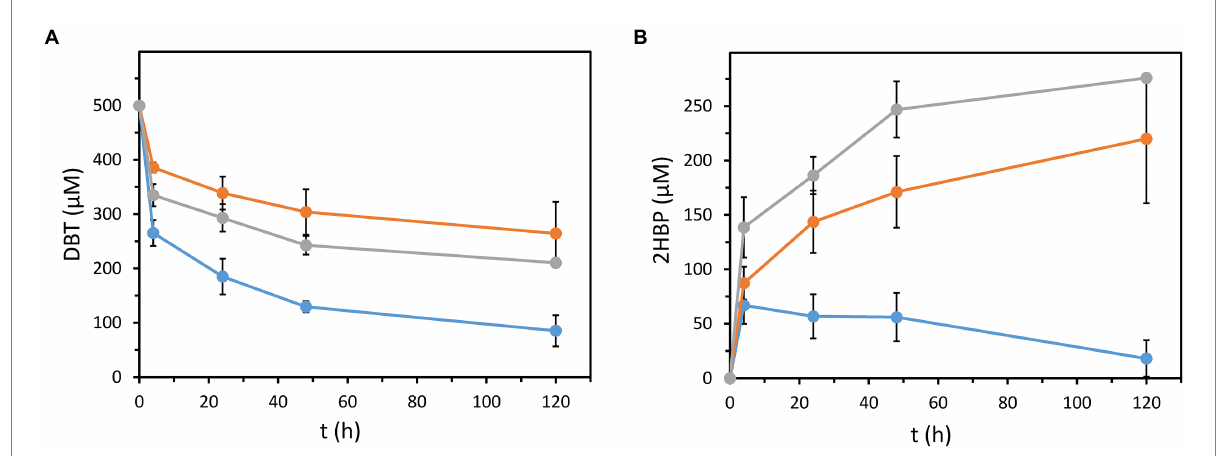
FIGURE 3 DBT degradation and 2HBP accumulation in resting cells assays. Strains tested were: P. azelaica AJdsz (blue circles), P. azelaica AJd hbpA dsz (gray triangles) and P. putida KT2440 harboring plasmid pIZdszB1A1C1-D1 (orange squares). (A) Evolution of DBT concentration in resting cells assays containing 500 μ M of DBT as initial sulfur substrate. (B) Evolution of 2HBP concentration. Values are the mean of three different experiments. Error bars indicate standard